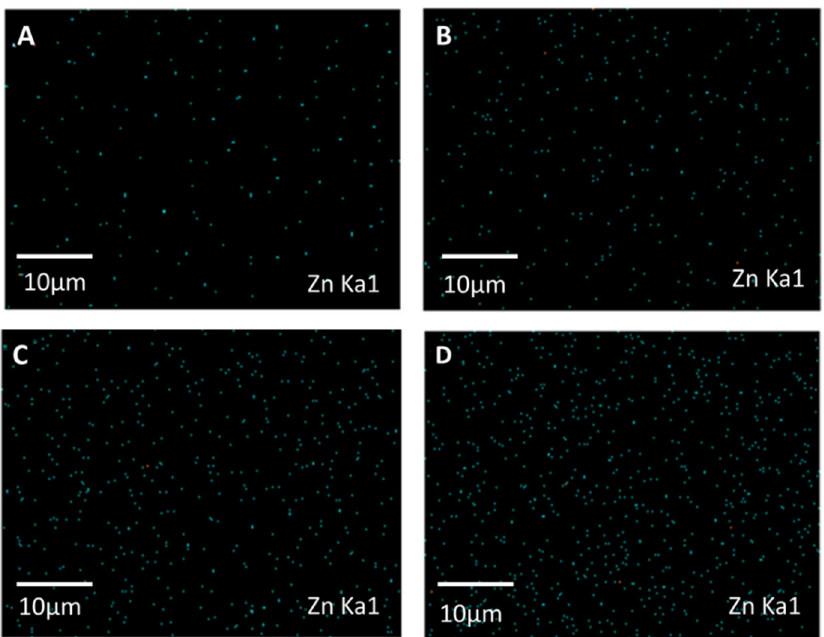
Figure 6. EDX analyses of ( A ) CTA/CDA-5 wt.% NH ₂ -ZIF-8, ( B ) CTA/CDA-10 wt.% NH ₂ -ZIF-8, ( C ) CTA/CDA-15 wt.% NH ₂ -ZIF-8, and ( D ) CTA/CDA-20 wt.% NH ₂ -ZIF-8.